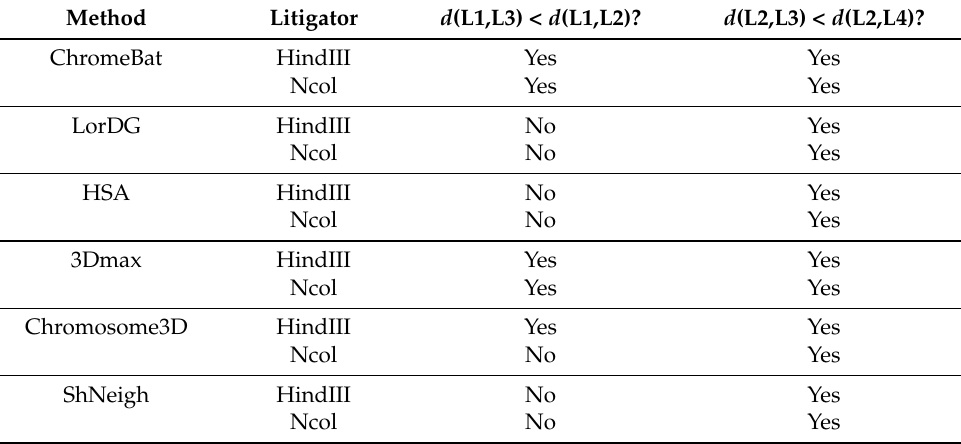
Table 2. Fish validation summary. Let function d ( X , Y ) denote the distance between loci X and loci Y . A “yes” in the right two columns means that the generated structure is consistent with the FISH data, and a “no” means it is